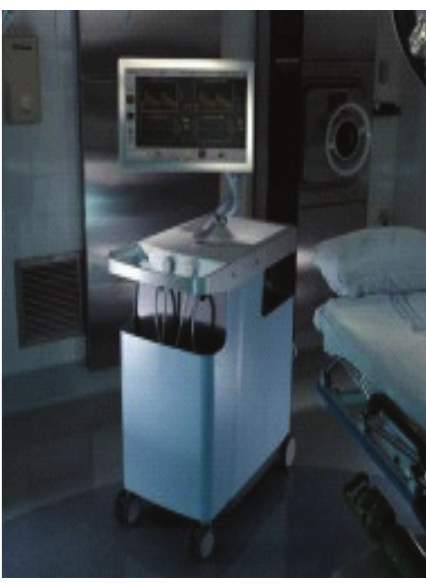
Figure 5: The “Presto” Cranial blood flow monitor. Courtesy of Physiosonics.